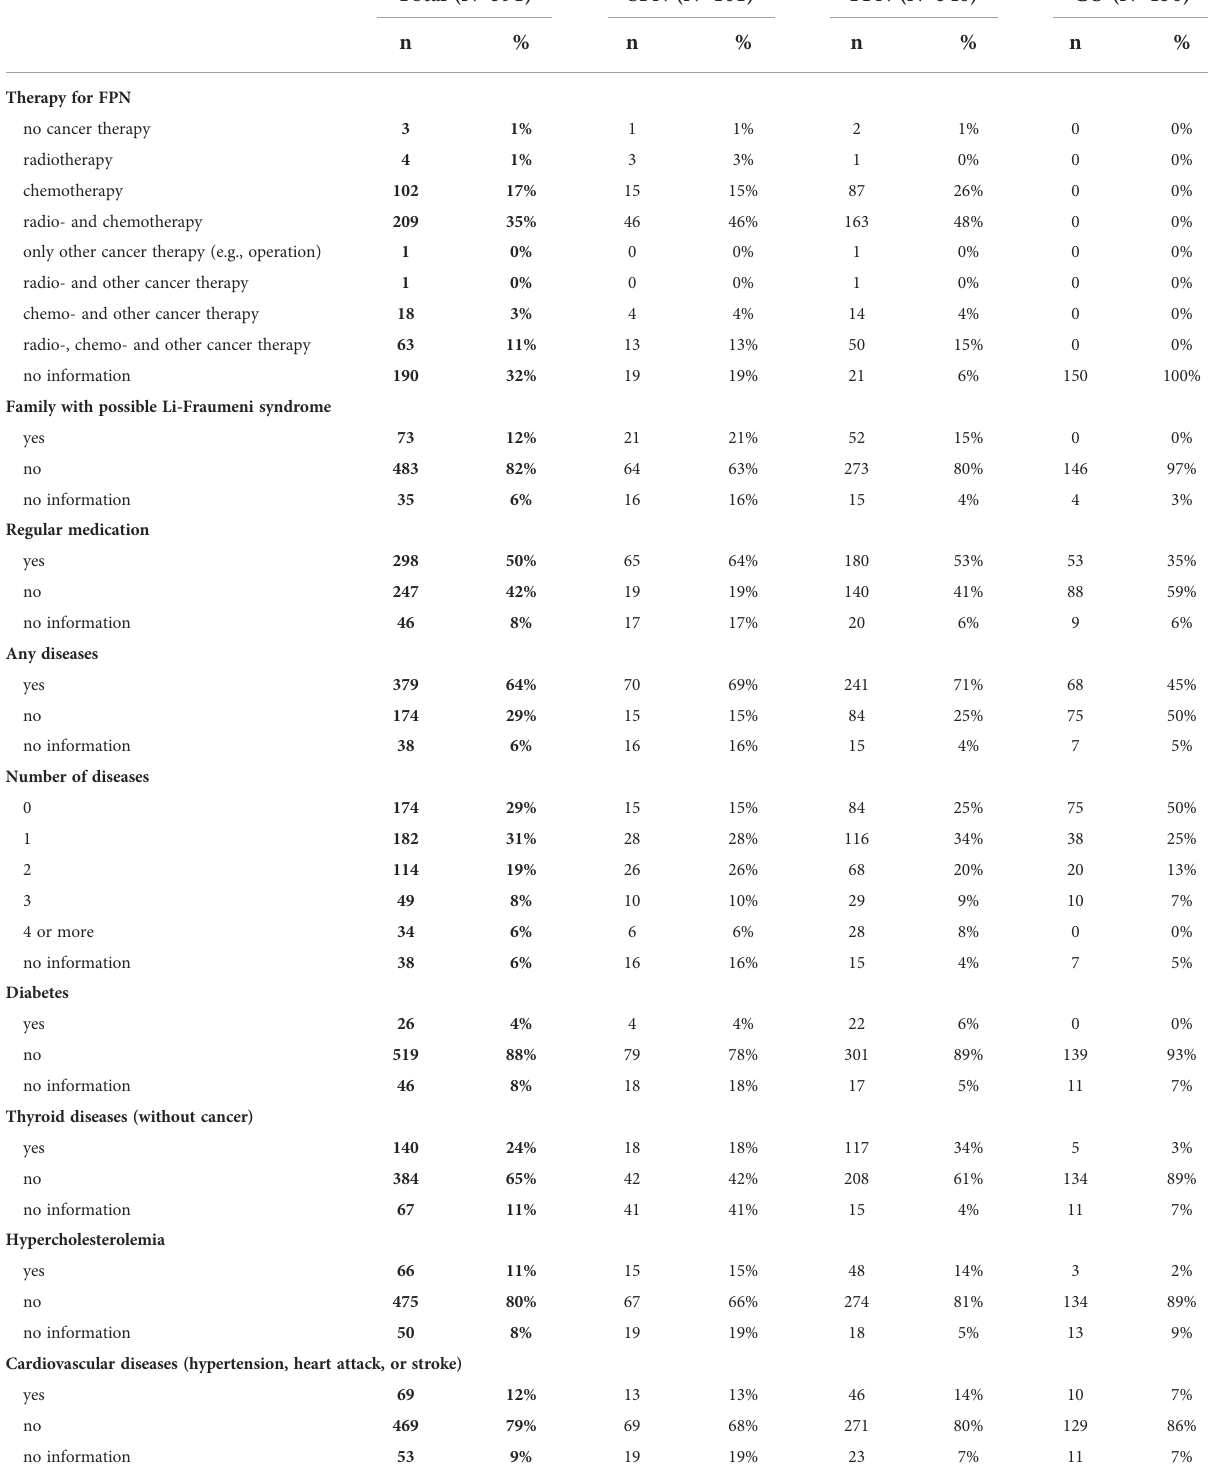
TABLE 2 Distribution of variables on health status of cases (SPN and FPN) and controls